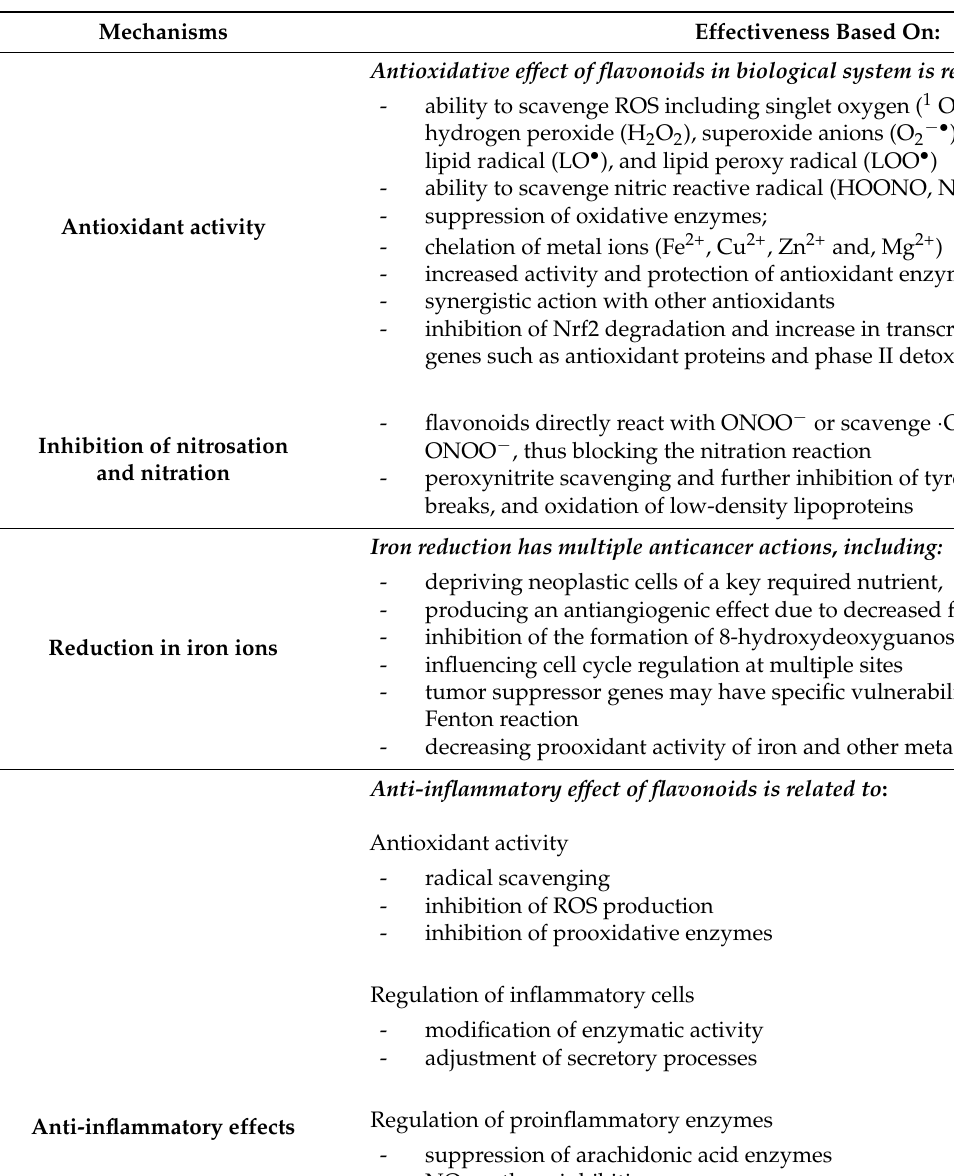
Table 3. Potential tumor preventive mechanism(s) of propolis and related